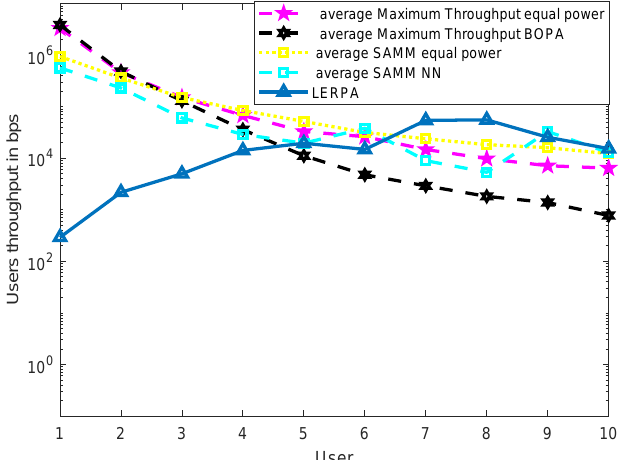
Figure 21. The users’ throughput with neural network for SAMM along with LERPA of [11] in multiple relays